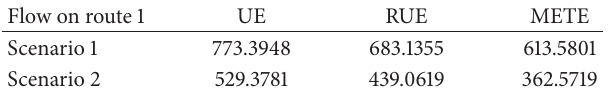
Table 2: Equilibrium flows on route 1 for different route choice criteria.